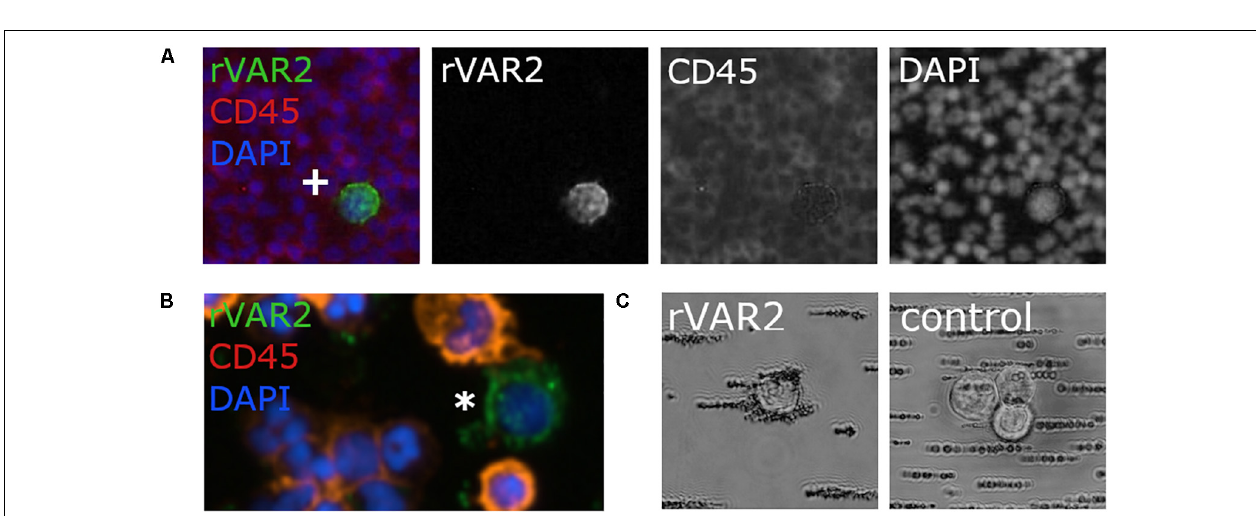
FIGURE 7 | Recombinant VAR2CSA (rVAR2) can be used for staining and capture of potential circulating tumor cells (CTCs). (A) Immunofluorescence staining of the colorectal cancer cells COLO205 (marked with cross) with rVAR2 (green), anti-CD45 (in red) to mark normal blood cells, and DAPI (in blue) to mark cell nuclei. (B) One potential CTC hit (green by rVAR2 stain; marked with white asterisk) in a blood sample from a colorectal cancer patient with the same staining as described in panel A. (C) Magnetic beads coated with rVAR2 bind specifically to COLO205 cells, compared to non-rVAR2 control beads. Pictures were kindly provided